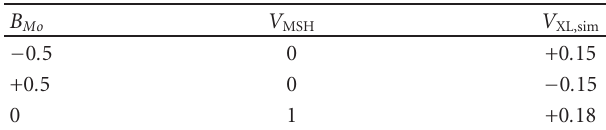
Table 1: Summary of the results from the simpler cases. B Mo : guide field, V MSH : velocity jump across the magnetopause, V XL,sim : the X - line speed measured in the simulation